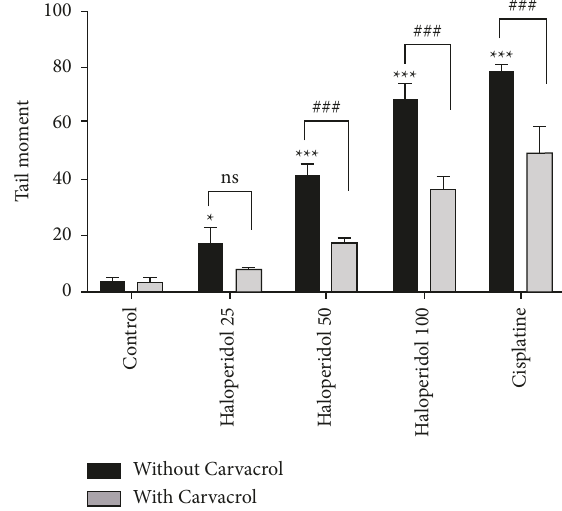
Figure 5: The changes in the tail moment in human lymphocytes after treatment by carvacrol and haloperidol; values are presented as the mean ± SD; ∗ significantly different compared to the control group without carvacrol ( P < 0 . 05); ∗∗∗ significantly different from the control group without carvacrol ( P < 0 . 001); ### significantly different from the haloperidol-treated group without carvacrol ( P < 0 . 001); ns: not